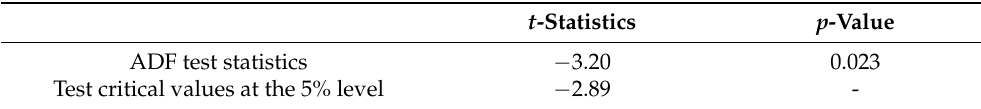
Table A1. The results of ADF test for sawlog prices.